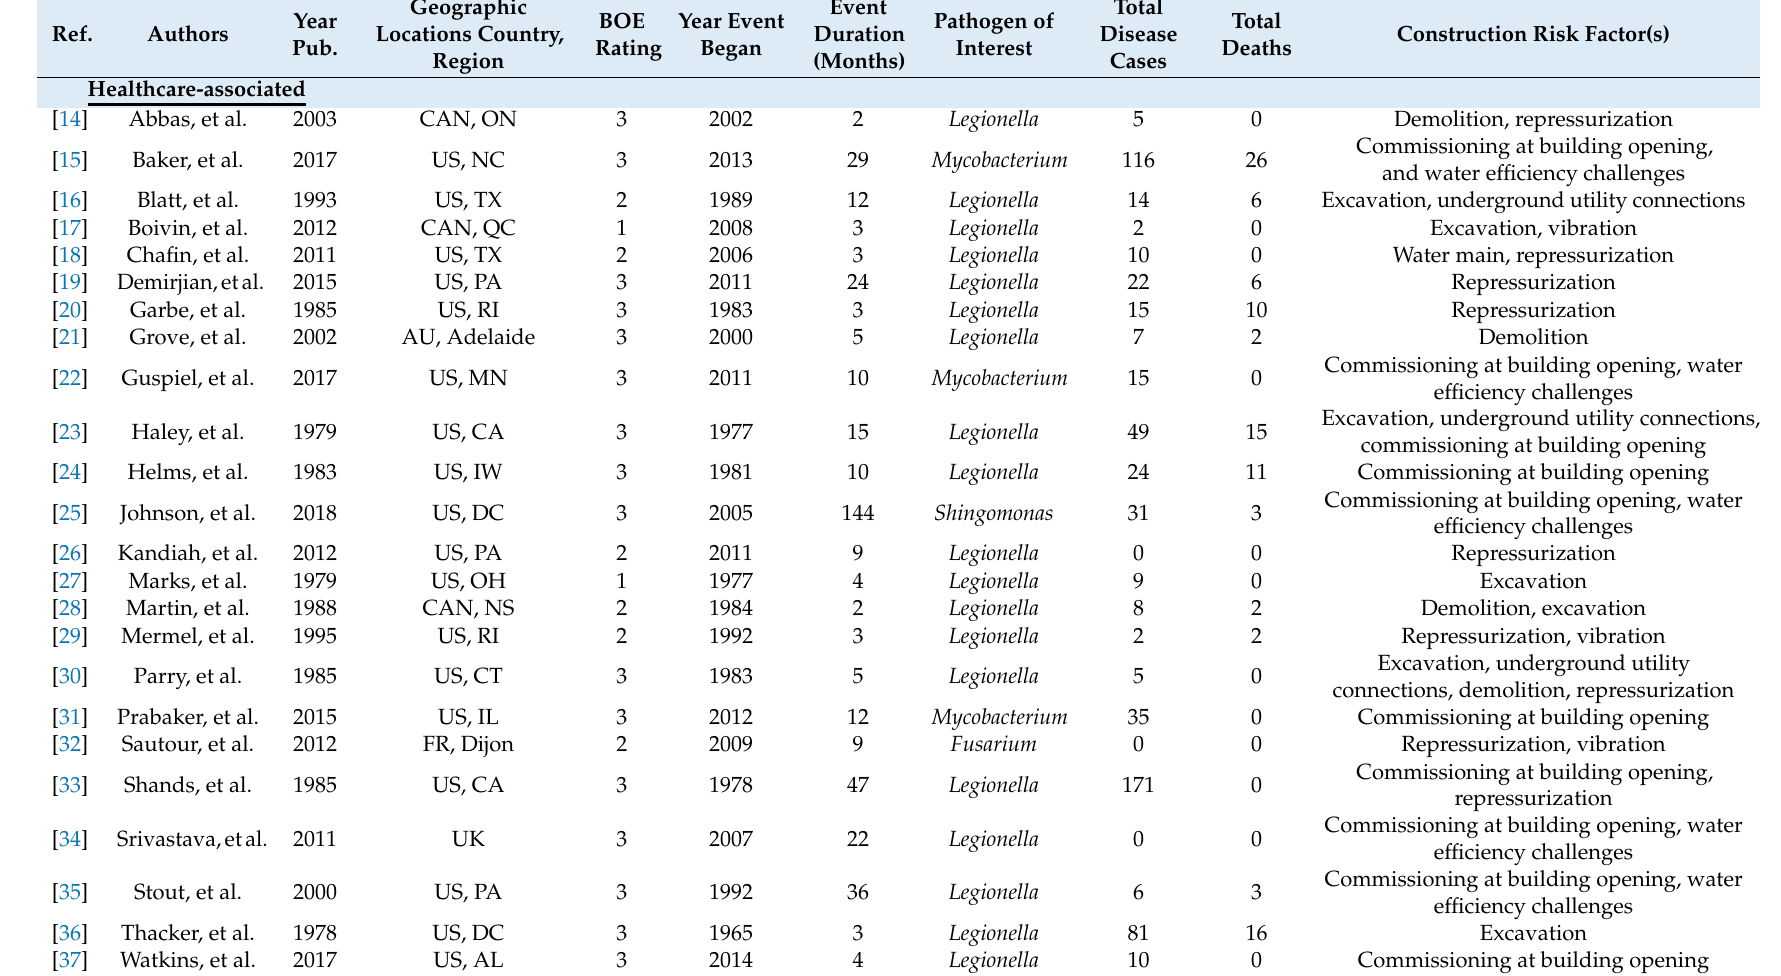
Table 1. Article / study characteristics and quality assessment of